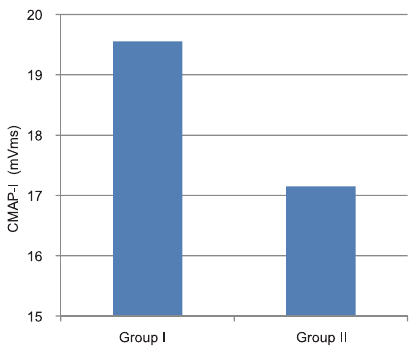
FIGURE 4. Compound muscle action potential areas (after proximal stimulation). Median value CMAP-I areas for Group I was 19.55 mVms, and Group II 17.15 mVms. The differences were statistically signi fi cant (p = 0.0032).